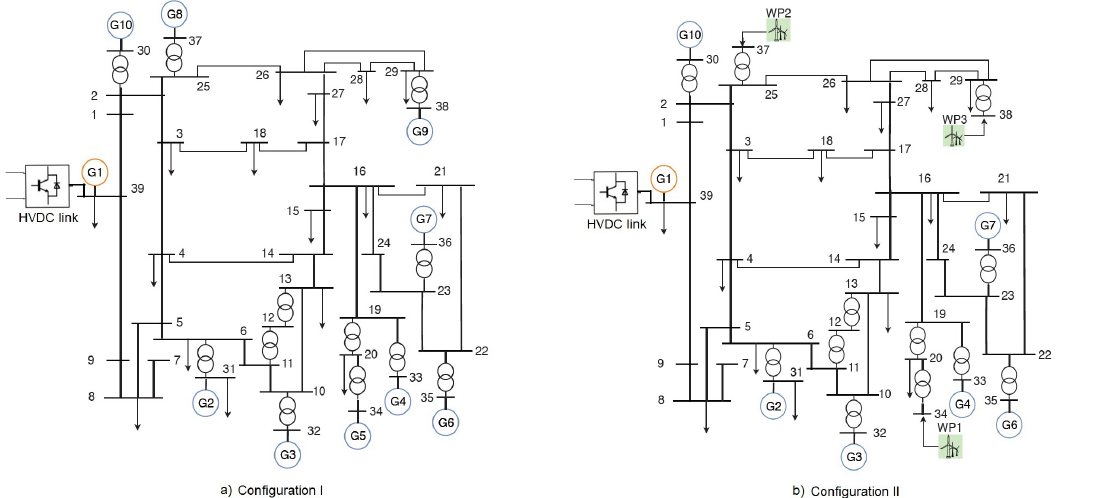
Figure 7. Configurations of the IEEE 39-bus dynamic power